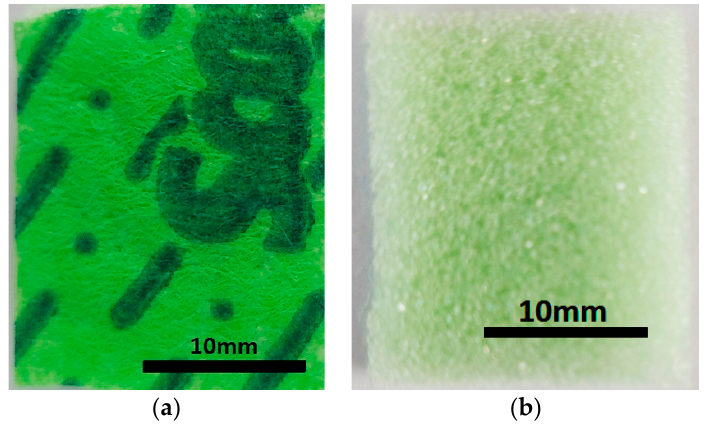
Figure 3. Photo images: ( a ) Super absorbent cloth (AC); ( b ) polyurethane sponge (PS). The absorbent PS from Figure 3b consists of cells and microfibers, as revealed by the SEM analysis (Figure 4a). Fine and ultrafine particles can be stored in the PS cells. The PS microfibers (Figure 4b) contain carbon and oxygen atoms. The Al atoms are due to the support plate.